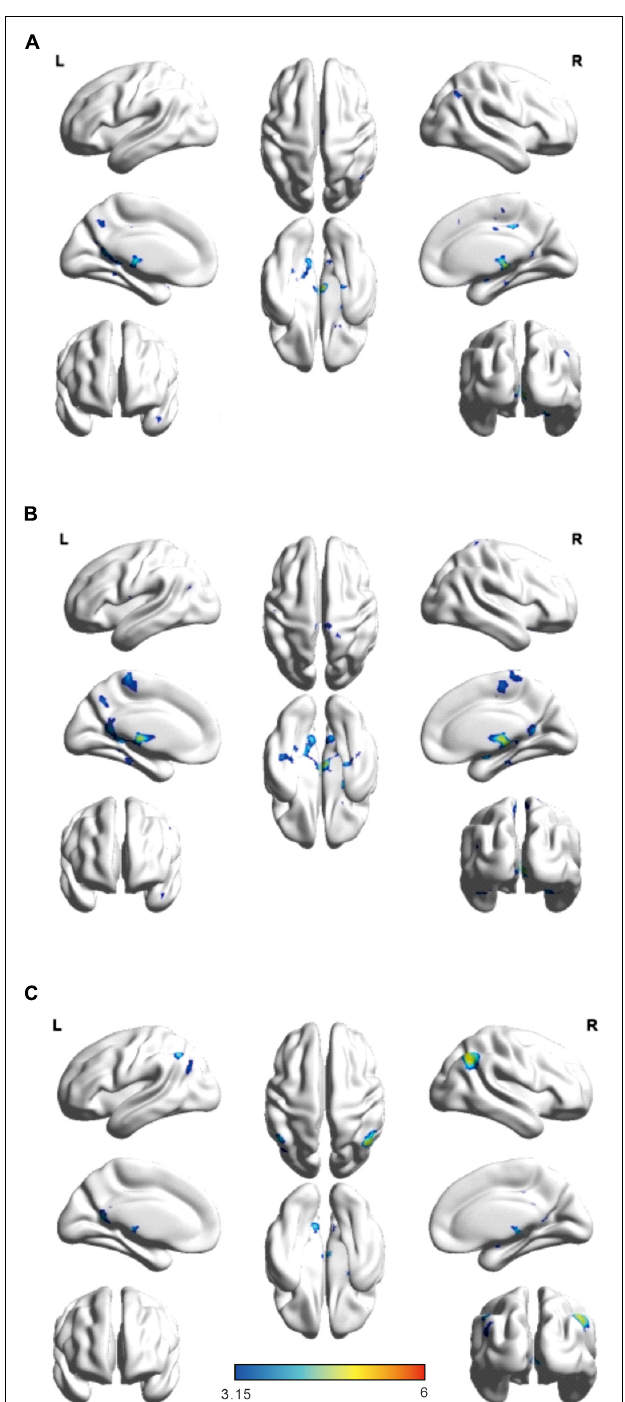
FIGURE 3 | Significant brain network regions are rendered on the surface of the automated anatomical labeling atlas in BrainNet Viewer. (A) Significant difference network connectivity in the left executive control network with the whole brain. (B) Significant difference network connectivity in the right executive control network with the whole brain. (C) Significant difference network connectivity in the precuneus network with the whole brain. The significance threshold was set at p < 0.05 (false discovery rate-corrected, cluster size > 20). R, right; L,